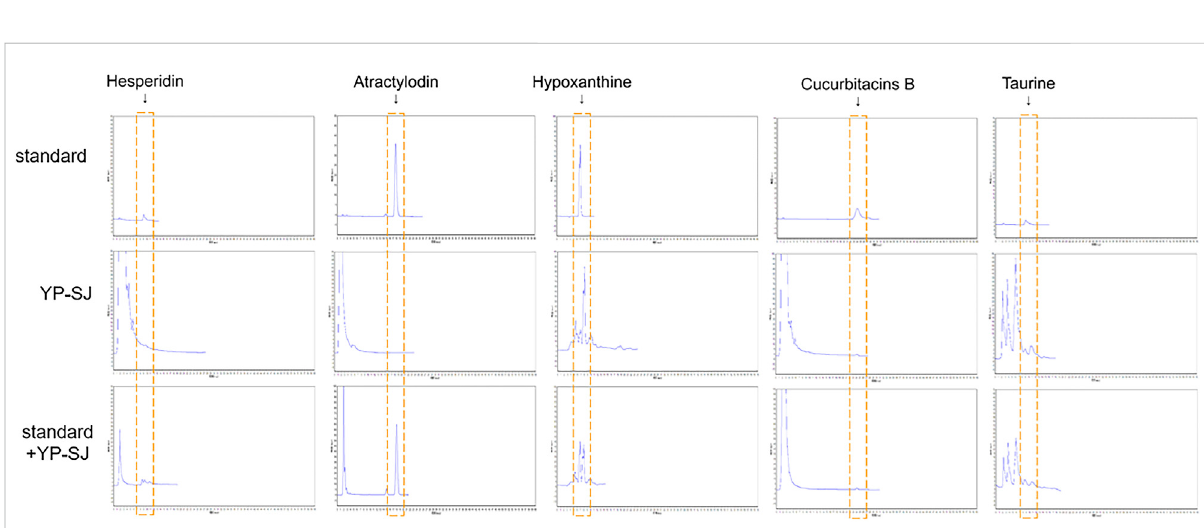
FIGURE 7 HPLCestimationofYP-SJformula.Thepresenceofhesperidin,atractylodin,hypoxanthine,cucurbitacinsBandtaurinewereadoptedasquality controls for YP-SJ formula. The abovementioned ingredients were detected in standard, YP-SJ and standard + YP-SJ